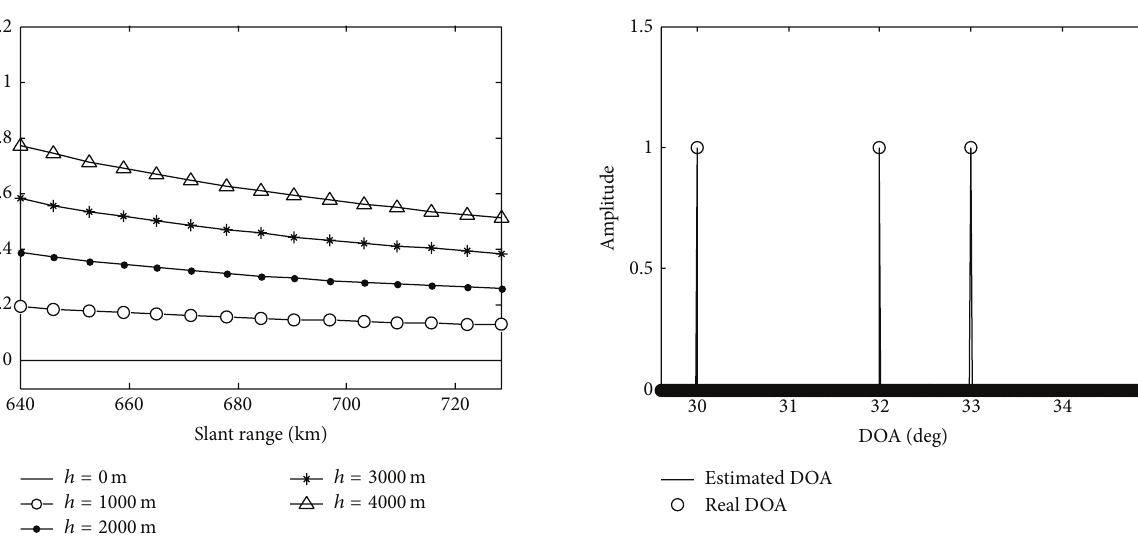
Figure 6: Estimation results of DOA based on CS.